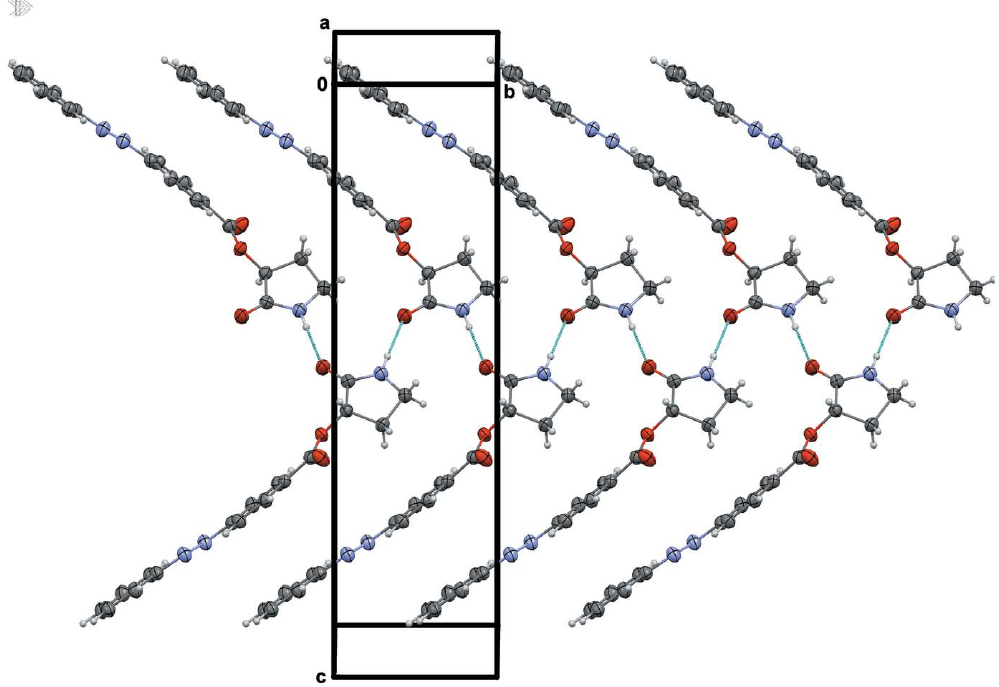
Figure 2 A partial view of the crystal packing of the title compound. Hydrogen bonds are shown as dashed lines (see Table 1).